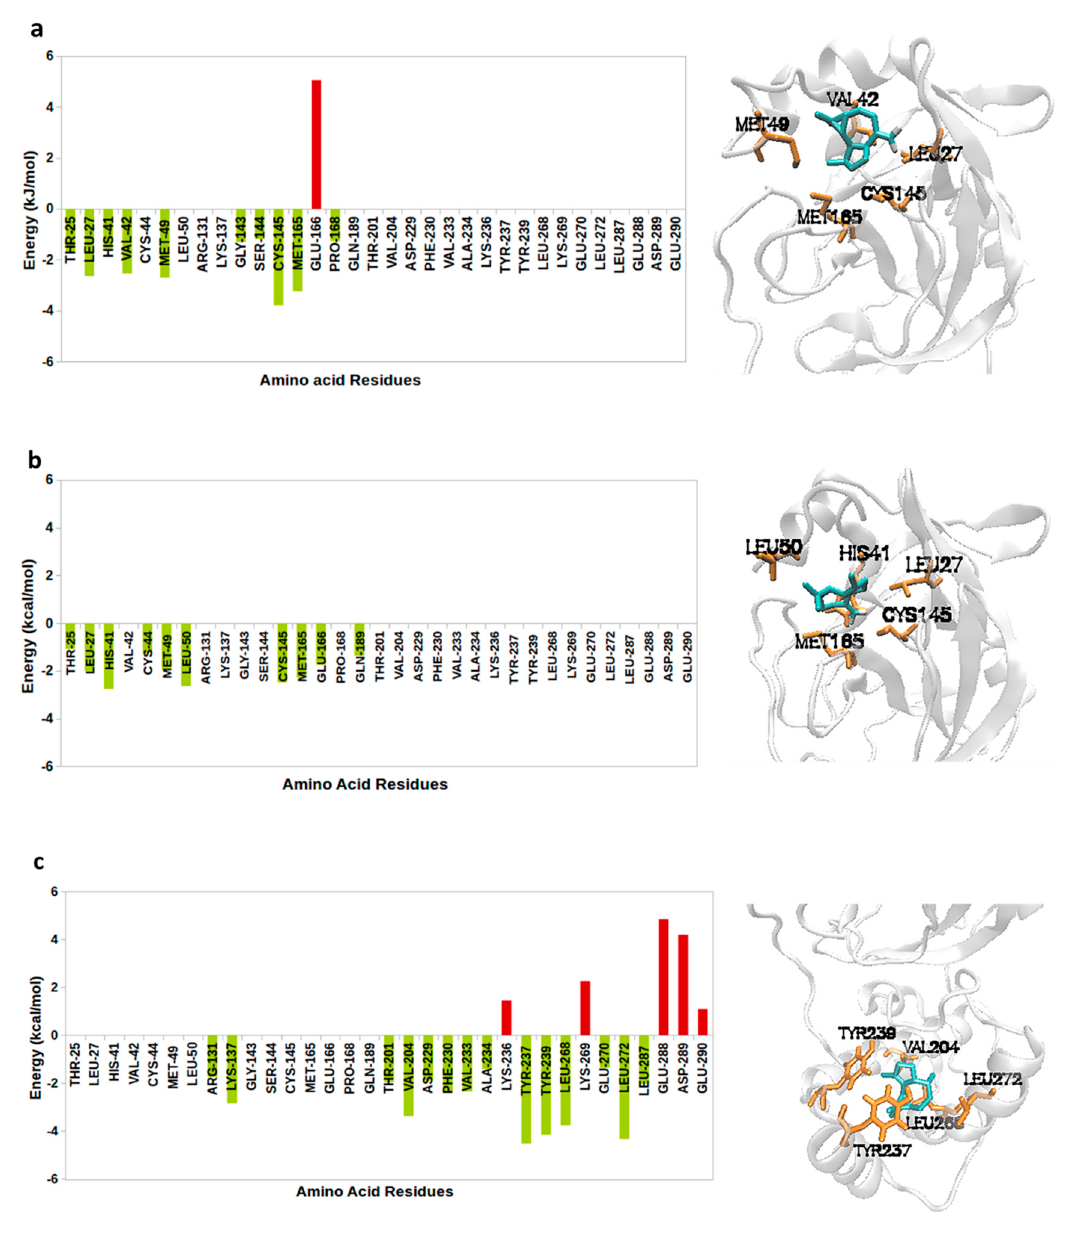
Figure 6. Per residue energy contributions (in kJ / mol) of the inhibitors. Red bars represent amino acids with unfavorable binding energies while light green bars represent amino acids with favorable binding energies; (right) final molecular dynamics (MD) snapshots of the major residues that contributed to the binding of Mpro in complex with ( a ) allo-aromadendrene, ( b ) aromadendrene, and ( c ) α -gurjunene. Table 4. Estimated binding energies of co-crystalized ligands against selected eucalyptus